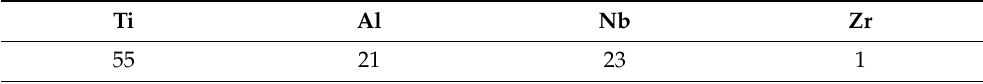
Figure 1. Phase structure of Ti2AlNb-based alloy: ( a ) β; ( b ) α 2 ; ( c ) O [22]. Table 1. Chemical composition of Ti2AlNb alloy by EDS (atomic content ratio,